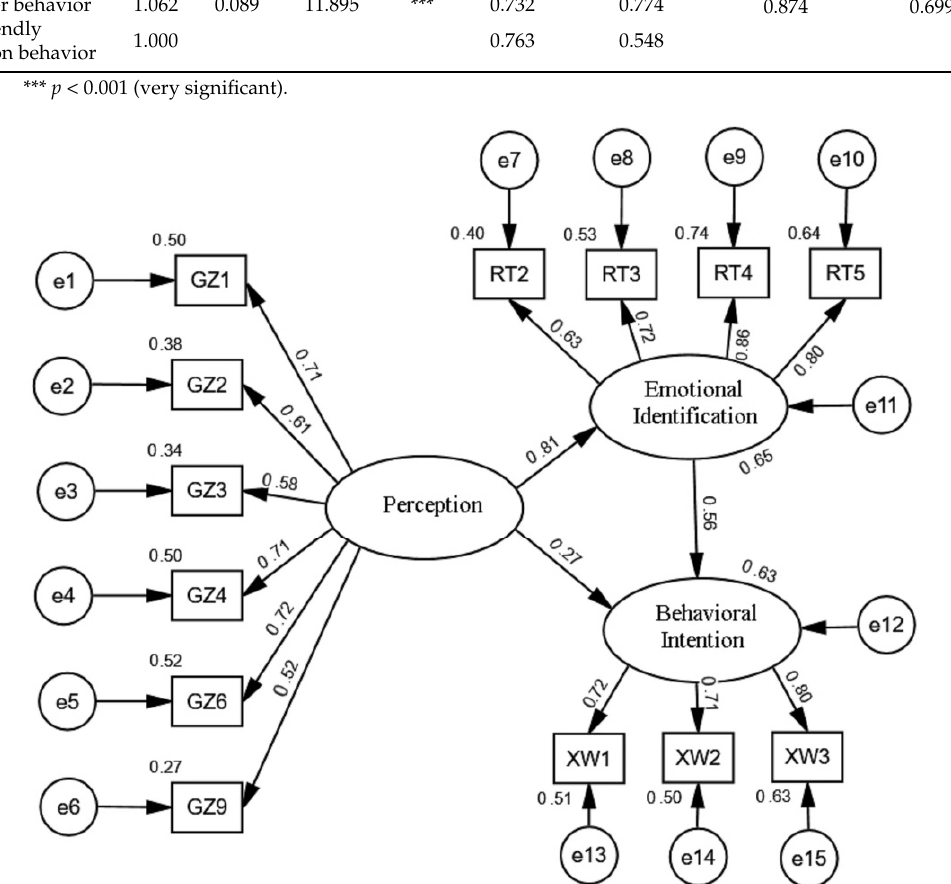
Figure 3. Revised emotional identification model of the edible landscape on